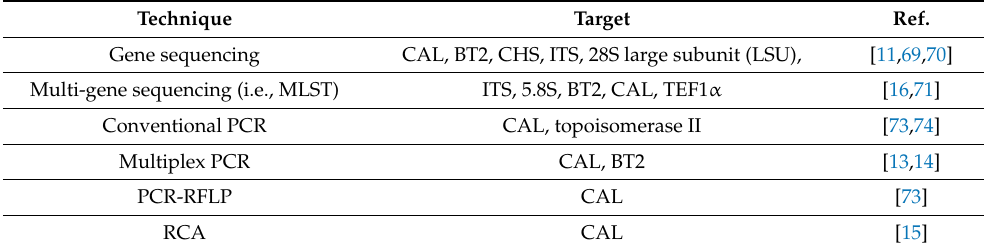
Table 3. Molecular techniques developed to diagnose